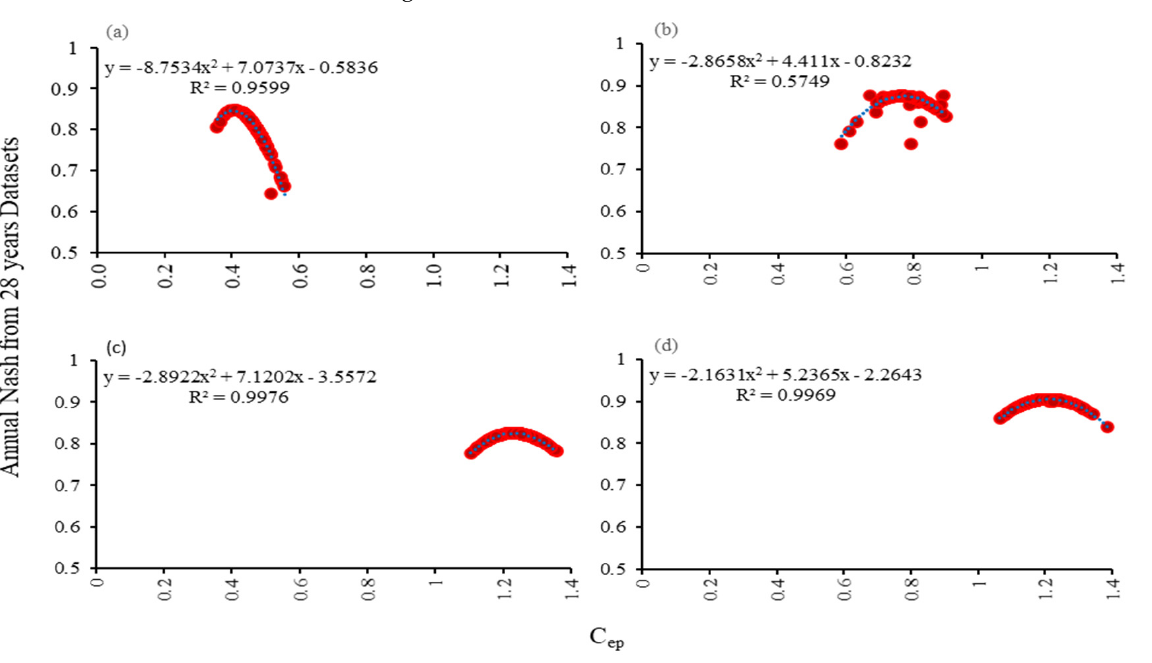
Figure 7. Polynomial regression analysis for simulated C ep values in ( a ) Doki River Basin ( b ) MOPEX ID 3504000 ( c ) MOPEX ID 2387500 and ( d ) MOPEX ID 2448000.